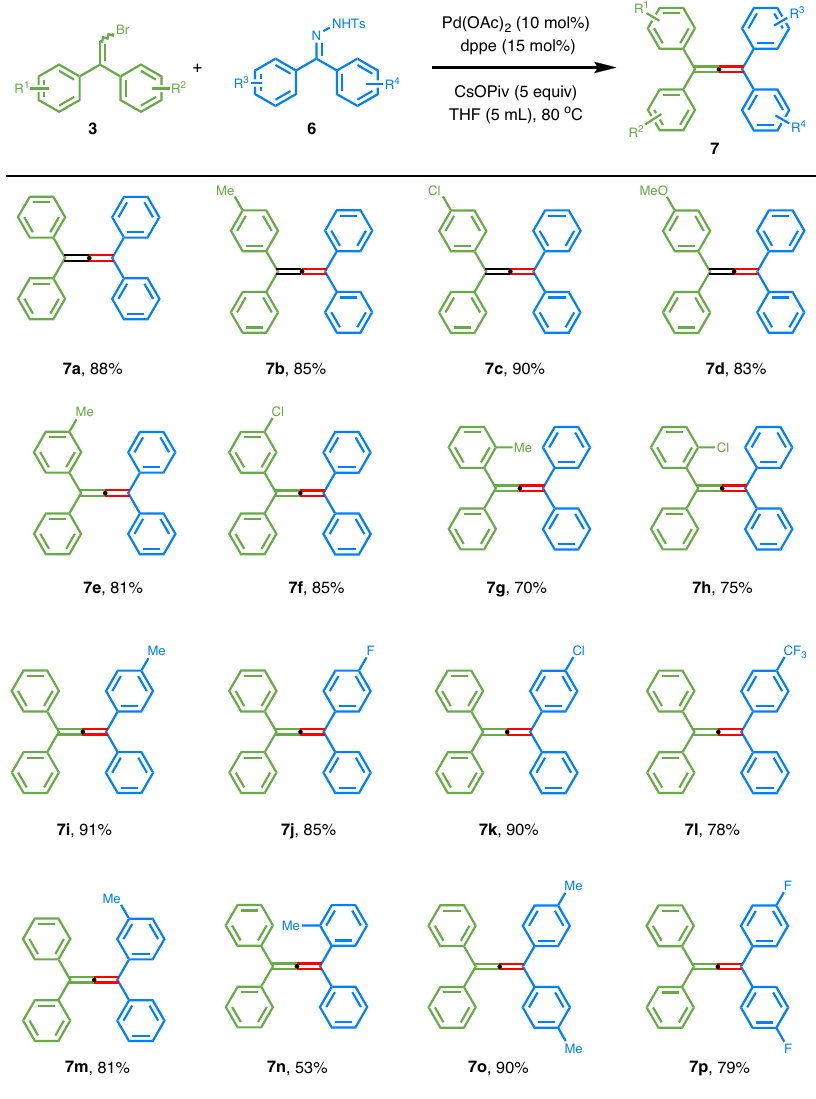
Fig. 4 Cross-coupling of 2,2-diarylvinyl bromides with N -tosylhydrazones. a Reaction conditions: 3 (0.20 mmol), 6 (0.30 mmol, 1.5 equiv.), Pd(OAc) 2 (0.02 mmol, 0.1 equiv.), dppe (0.03 mmol, 0.15 equiv.), CsOPiv (1.00 mmol, 5 equiv.), THF (5 mL), 80 o C. Isolated